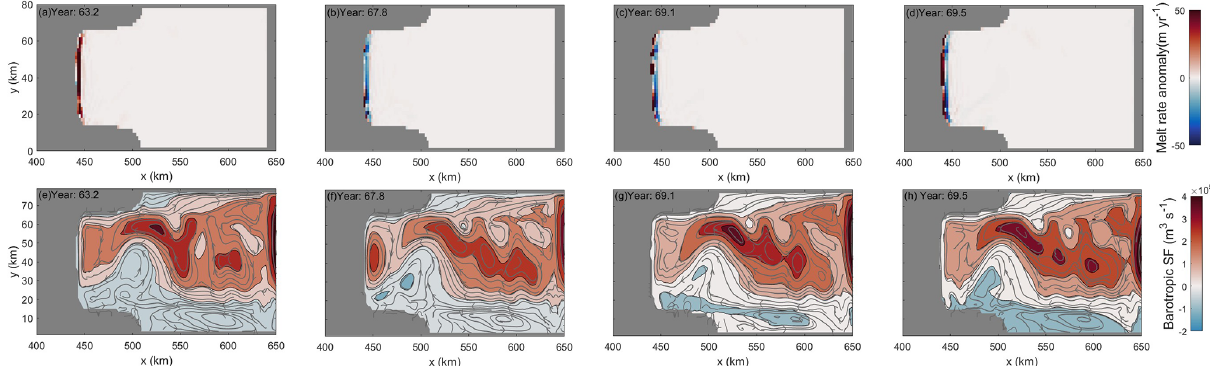
Figure 5. Spatial pattern of basal melting anomalies with respect to the mean melt rates over the oscillation cycle period (myr − 1 ) (a–d) and barotropic streamfunction XY sections (m 3 s − 1 ), with circulation contours extracted from the barotropic flow field (e–h) around one oscillation cycle from CTRL. The corresponding time points are shown in Fig. 3.